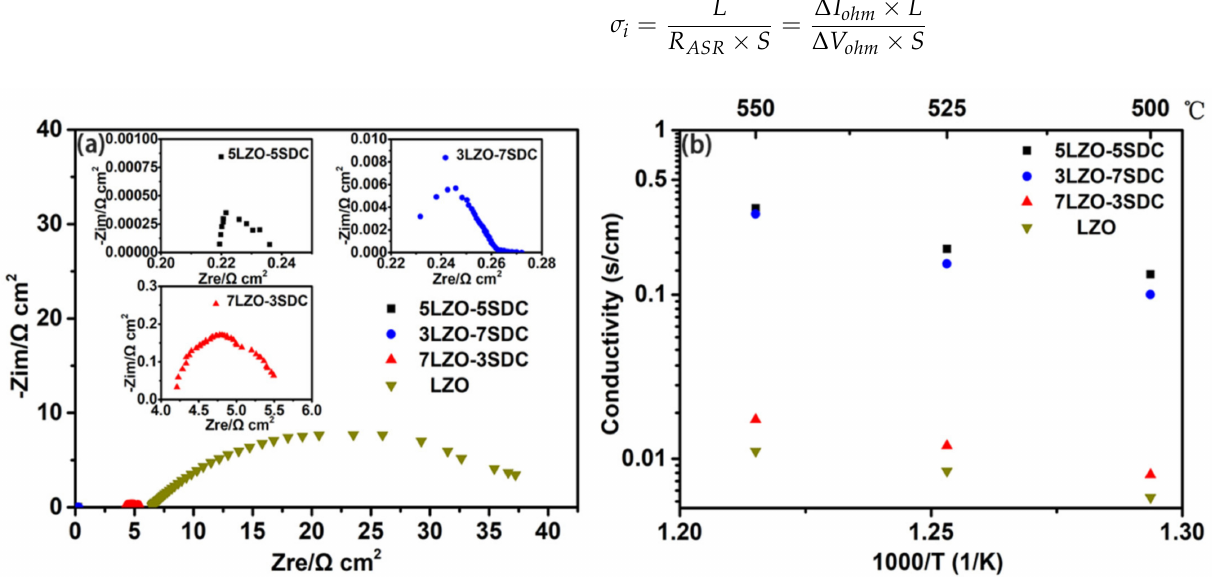
Figure 4. Typical impedance spectra of ( a ) LZO, 7LZO-3SDC, 5LZO-5SDC and 3LZO-7SDC pellets measured at 550 ◦ C in H 2 /air, and ( b ) the electrical conductivity of LZO, 5LZO-5SDC, 7LZO-3SDC, and 3LZO-7SDC attained from EIS